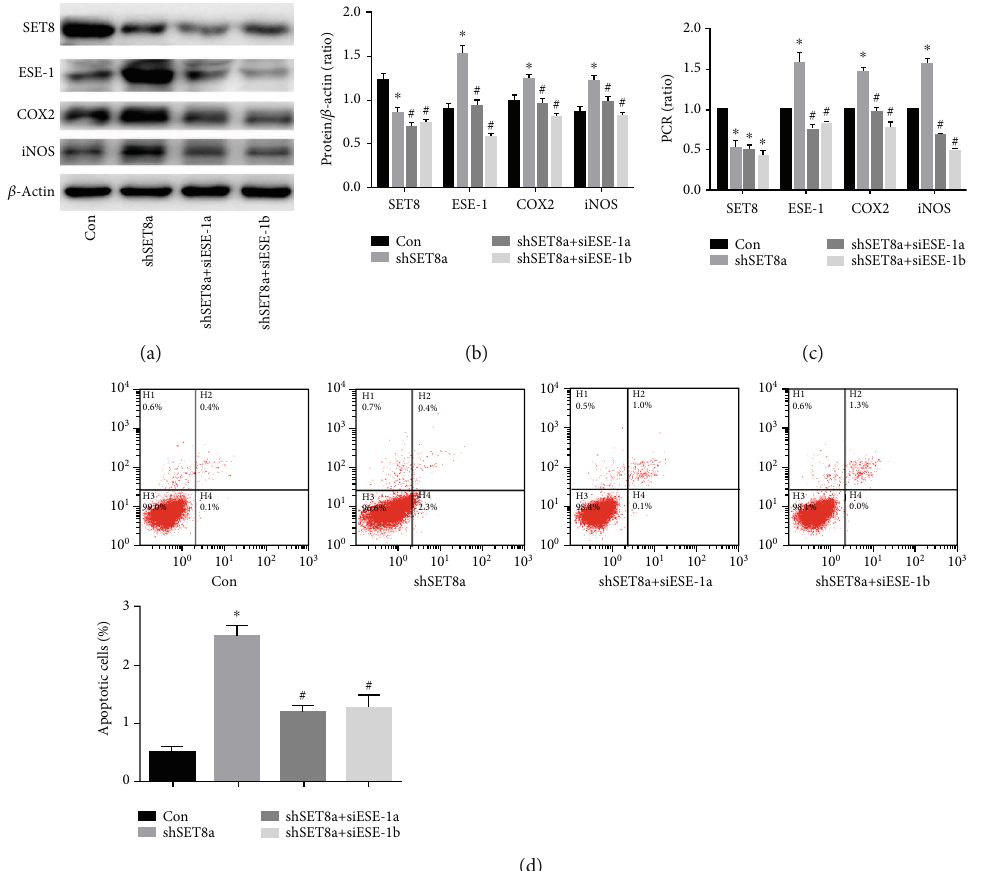
Figure 3: SET domain-containing protein 8 (SETD8) downregulation induced cyclooxygenase 2 (COX2) and inducible nitric oxide synthase (iNOS) expression via upregulation of E26 transformation-speci fi c sequence transcription factor-1 (ESE-1) in human umbilical vein endothelial cells (HUVECs). (a, b) Western blot analysis of SETD8, ESE-1, iNOS, and COX2 expression in HUVECs with SETD8 and ESE-1 knockdown. siESE-1 inhibited shSETD8-induced iNOS and COX2 protein expression in HUVECs. (c) qPCR analysis of SETD8, ESE-1, iNOS, and COX2 expression in HUVECs with SETD8 and ESE-1 knockdown. siESE-1 inhibited shSETD8-induced iNOS and COX2 mRNA expression in HUVECs. (d) Cell apoptosis analysis in HUVECs with SETD8 and ESE-1 knockdown. siESE-1 alleviated shSETD8-mediated cell apoptosis in HUVECs. shSETD8: short hairpin RNA SETD8; siESE-1: small interfering RNA ESE-1. ∗ P < 0 : 05 , compared with the control group; # P < 0 : 05 , compared with high glucose